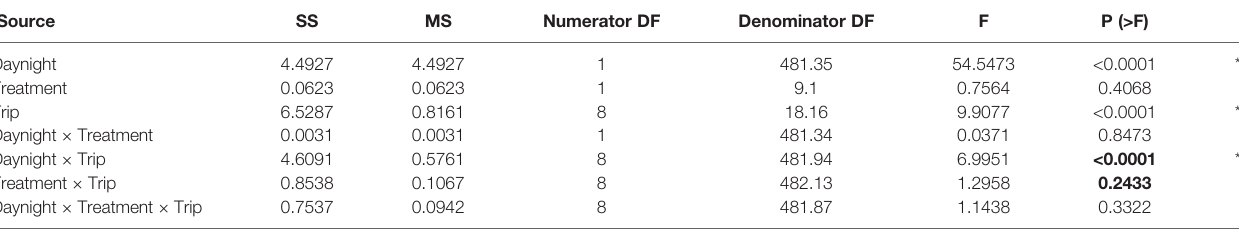
TABLE 2 | Linear mixed effects model for zooplankton biomass. Source